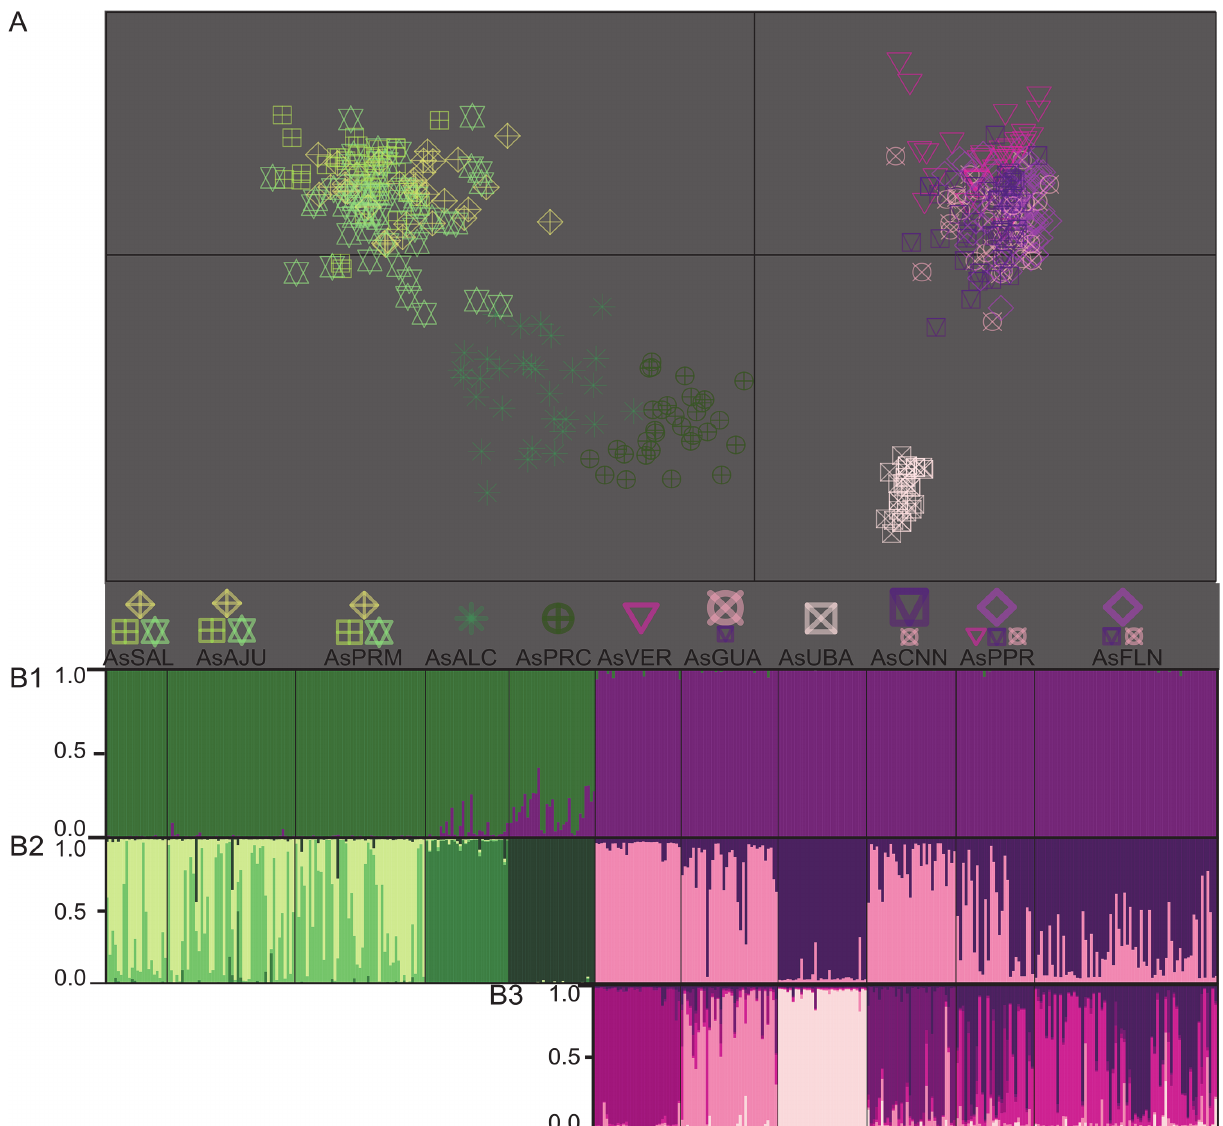
Fig 5. A . schaueriana population structure along the Brazilian coast. A) A scatterplot of the first two principal components of the multivariate analysis of DAPC [36], which resulted in a most likely k value of 10. Each symbol indicates the group to which each individual was assigned. The geographic origin of each individual is denoted for each locality sample such that more than 10% of the total number of individuals was composed of the inferred cluster. A larger symbol indicates that a cluster was predominant in the locality sample (pairwise cluster ratio larger than 1:5), whereas equal symbol sizes indicate similar cluster contributions to the total number of individuals in each sample. B1) Model-based clustering analyses [38,39] considering k = 2, where each individual is represented by a vertical line and each color refers to one inferred cluster; the posterior probability of group membership is indicated. These Bayesian analyses were extended to the inferred groups observed in B1, which correspond to samples north (green) and south (violet) of the NEESA. The posterior probabilities of group membership in this fine-scale analysis of AsN (k = 4) and AsS (k = 2) are shown in B2; further evaluations of AsS (k = 6) are displayed in